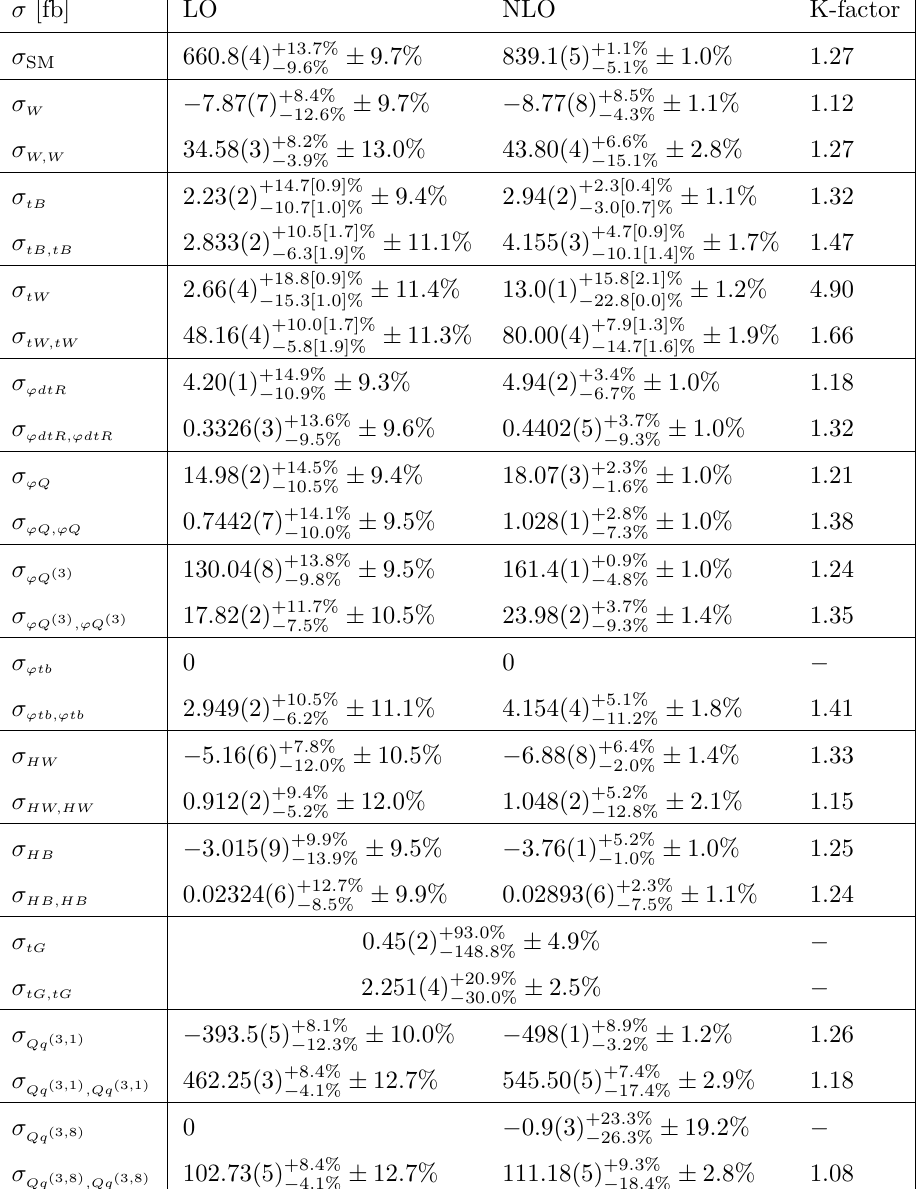
Table 5 . Cross-section results for tZj at 13 TeV, following the parametrisation of eq. (4.1). Central values are quoted followed by the upper and lower scale uncertainty bands obtained by varying the renormalisation scale between half and twice the central value, the EFT scale uncertainty where relevant and (cid:12)nally the PDF uncertainty. The MC error on the last digit is shown in the bracket. with the expectations from the 2 2 subamplitudes shown in table 7. We observe that ! (3) the squared contribution of the left handed quark current operator is signi(cid:12)cantly ’Q O enhanced by the p t cut. This is in contrast to the case of single-top production or T